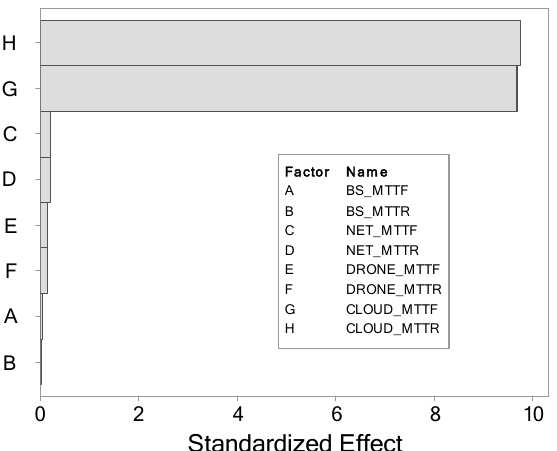
Figure 7. Pareto analysis shows the components as factors and the importance of each factor on